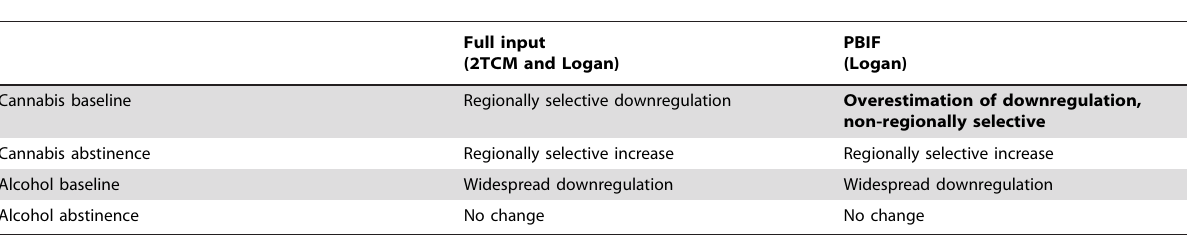
Table 2. Results from the alcohol and cannabis studies using PBIF.